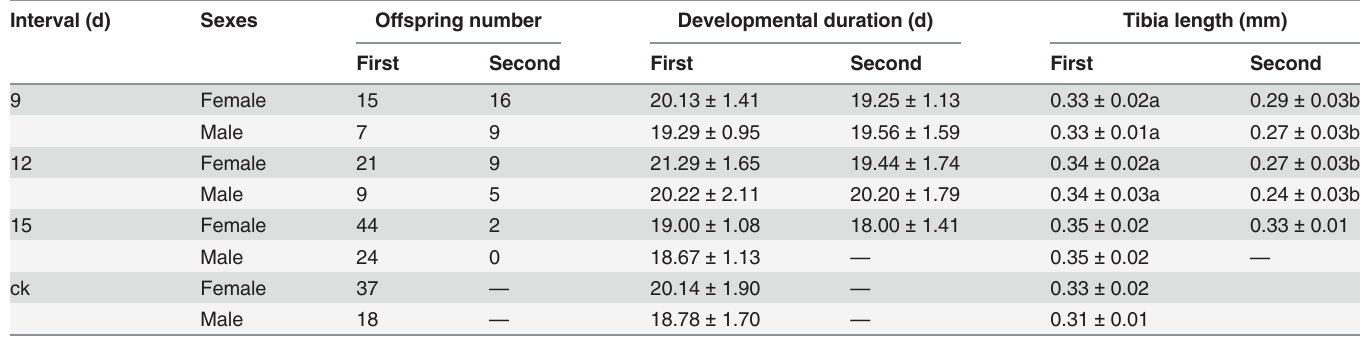
Discrimination of the offspring from the first and second emerging events The fragments migrated on the electrophoresis gel were about 150 bp for the Wuhu strain, while those for the Urumqi strain were about 190 bp (Fig 3). Nine days after the primary para- sitism by the Wuhu strain P . vindemmiae , females of Urumqi strain were used as secondary parasitoids. Offspring also emerged at two obvious emerging events (Fig 4). All of the offspring Table 2. Developmental duration and size of female and male P . vindemmiae offspring at the first and second emerging events from hosts ex- posed twice with different intervals. Interval (d) Sexes